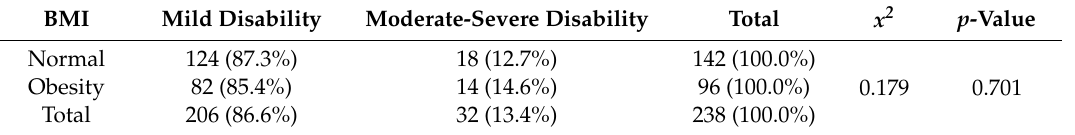
Table 5. Disability status in relation to obesity assessed by chi-squared analysis.